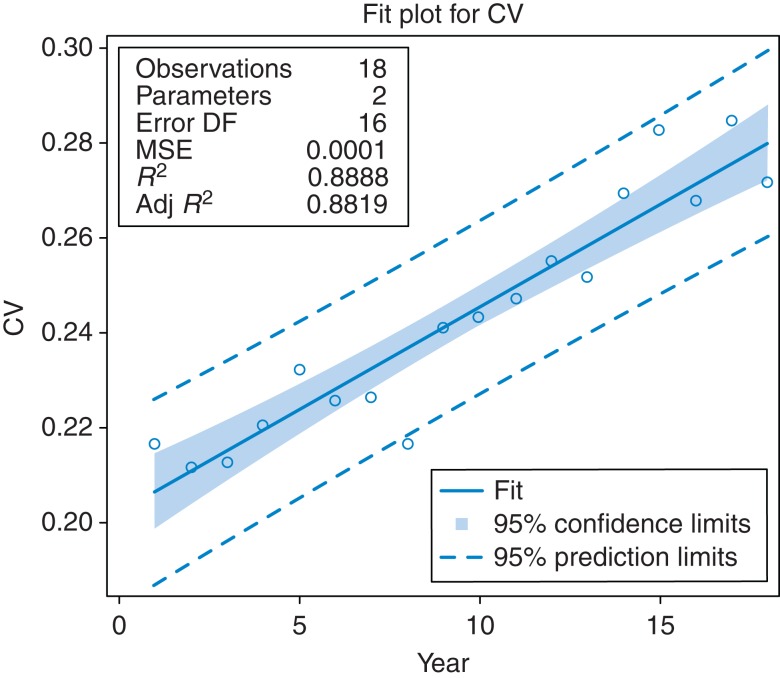
Fit plot for regression analysis of coefficient of variation.